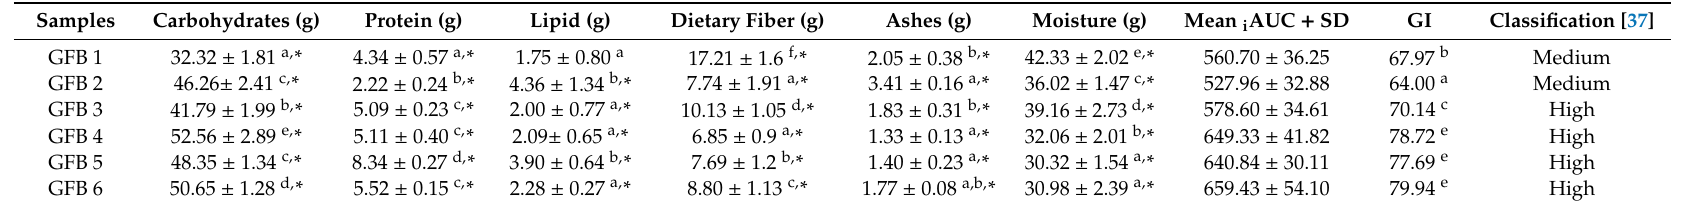
Table 2. Mean chemical composition and glycemic index for analyzed